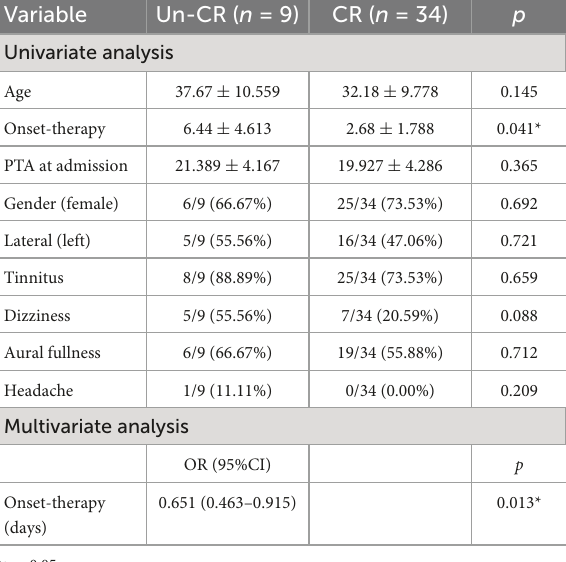
TABLE 2 Factors related to prognosis of acute low-frequency hearing loss (ALFHL).